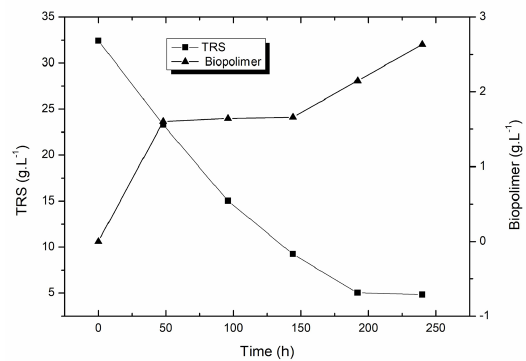
Figure 3. Kinetic curves based at the concentration of total reducing sugars for the medium (B).